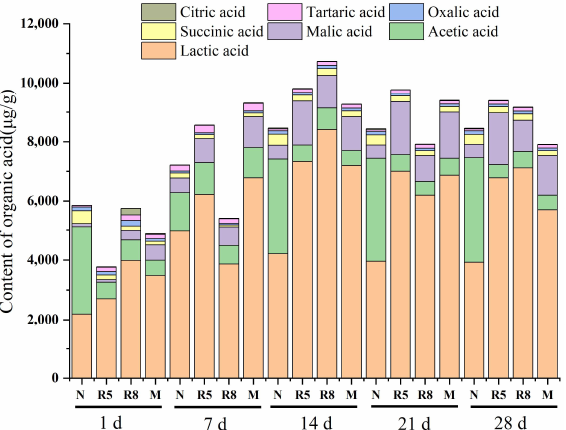
Figure 2. Changes in organic acid content in pickles during fermentation.